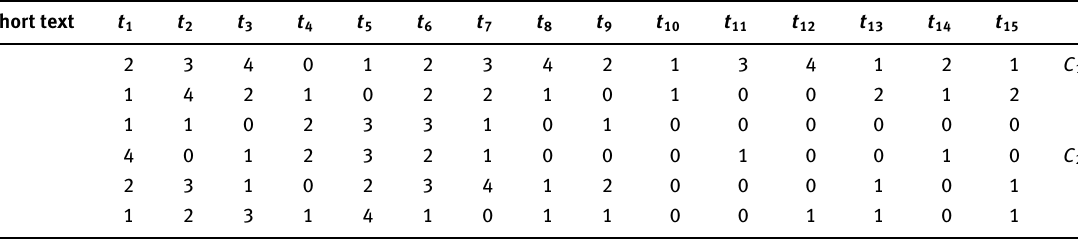
Table 1: Term Document Matrix ( S ).